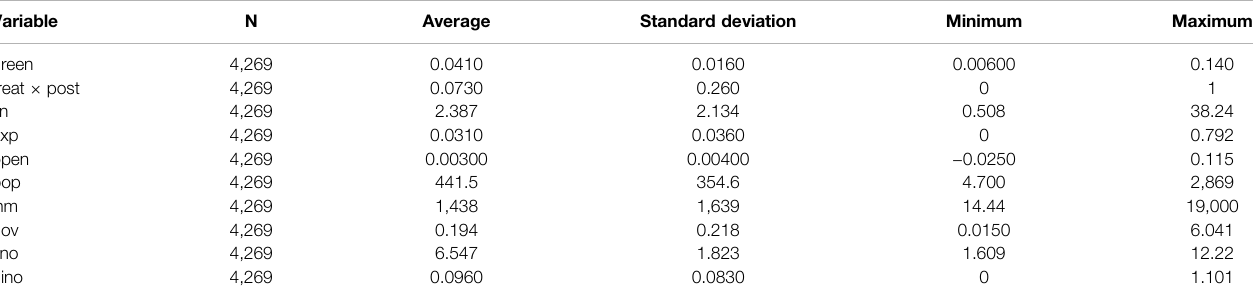
TABLE 3 | Descriptive statistics of variables.